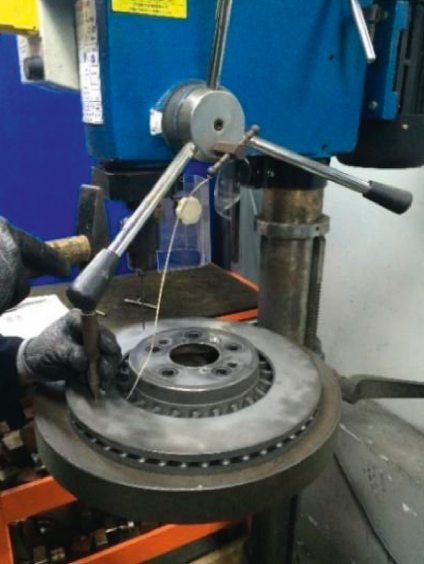
Figure 17: Thermocouple in the disc.